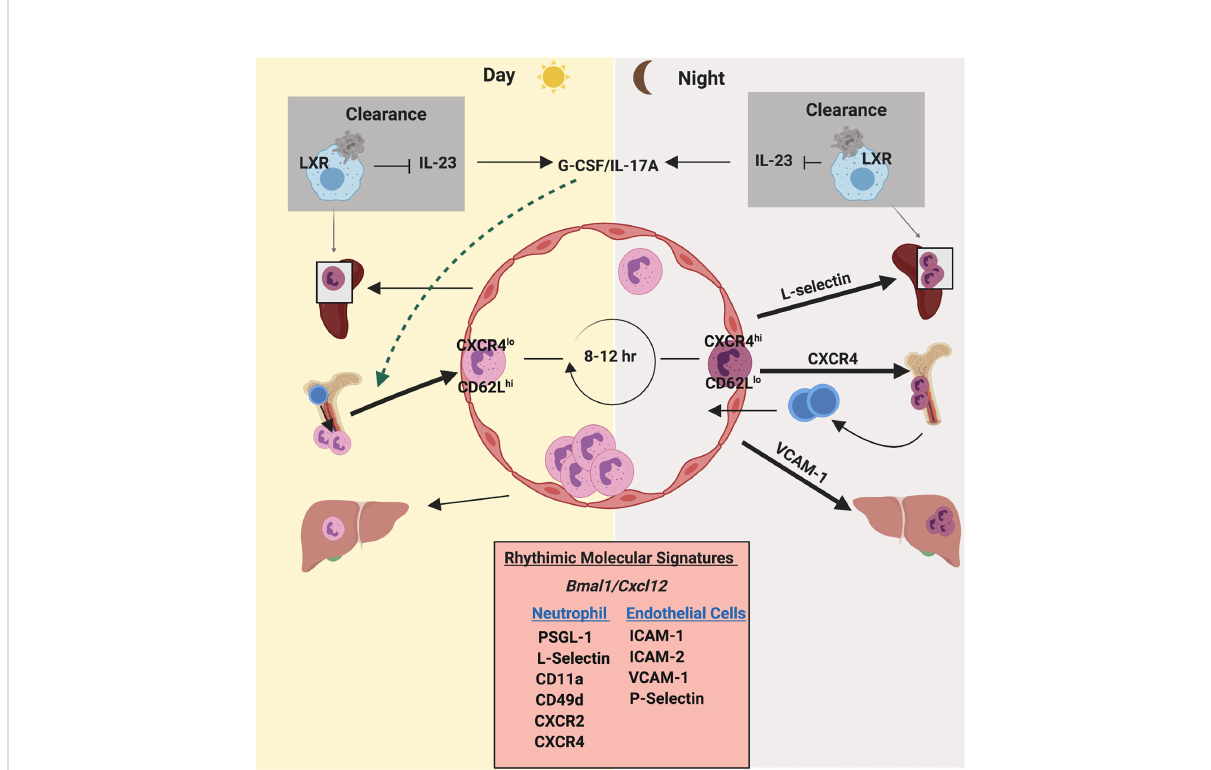
FIGURE 4 Circadian rhythm regulates neutrophil homeostasis and function. Neutrophils exhibit an oscillation in numbers in blood and tissues, which coincides with daily circadian rhythms. Neutrophil numbers in blood peak after few hours of initiation of light and then drop during the light phase. Under the in fl uence of clock genes (such as Bmal1) and granulopoietic cytokines (mainly G-CSF), CXCL12/CXCR4 regulates daily release and retention of neutrophils. Furthermore, a circadian fl uctuation of the expression of CD62L and CXCR4 on the surface of neutrophils dictates their counts in blood during steady state. CD62L high CXCR4 low neutrophils enter circulation during the light phase. After 8-12 hours, aged neutrophils (CD62L low CXCR4 high ) enter the bone marrow for clearance coinciding with daily circadian rhythms. Additionally, oscillatory expression of pro-in fl ammatory and adhesive molecules on the endothelium and on neutrophils exhibit a robust circadian rhythmicity during neutrophil release and